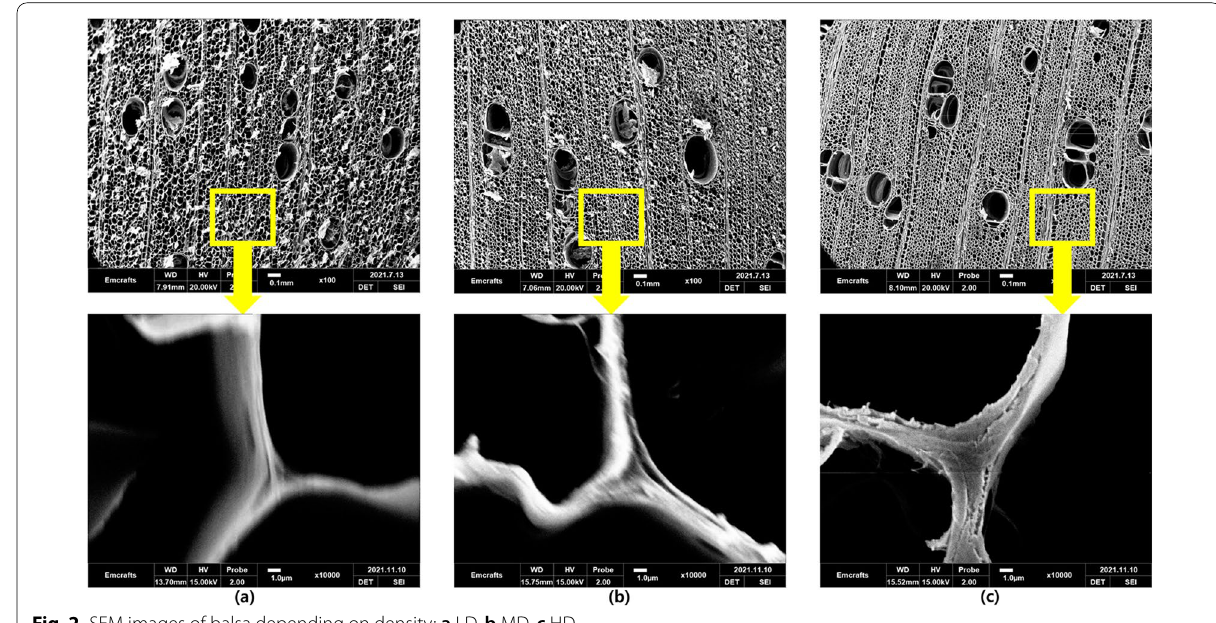
Fig. 2 SEM images of balsa depending on density: a LD, b MD, c HD